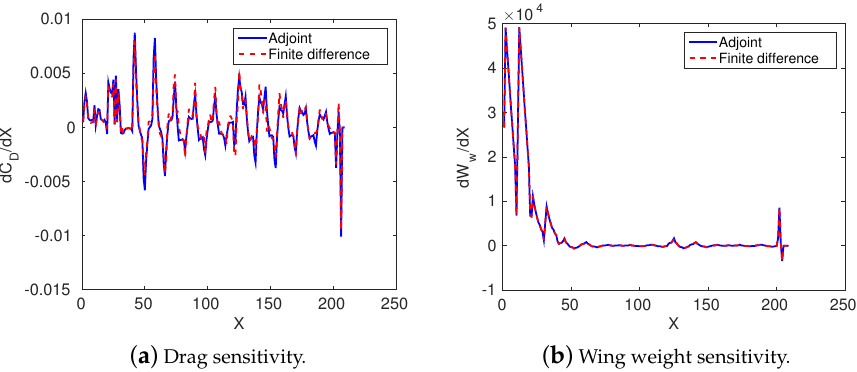
Figure 7. Sensitivity comparison for different design